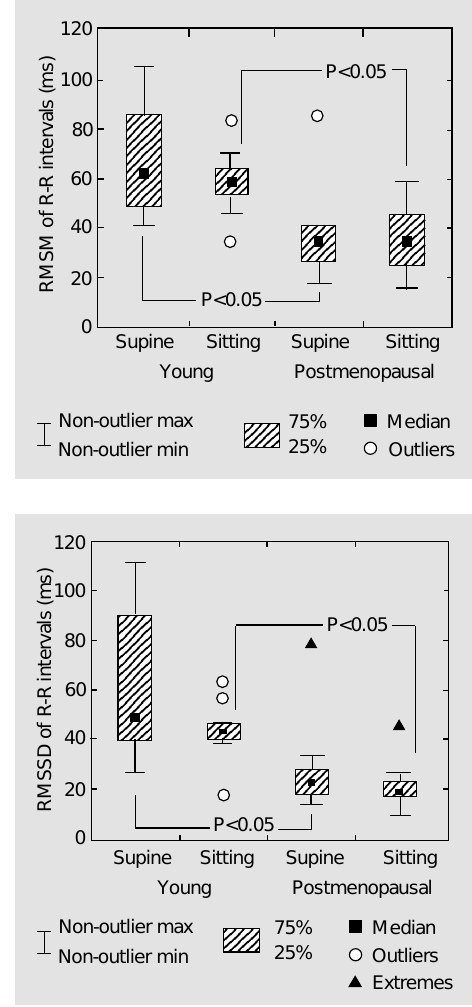
Figure 3. RMSM indexes, the standard deviation of R-R inter- vals, in ms, for the young group (N = 10) and the postmeno- pausal group (N = 10) under rest- ing conditions in the supine and sitting positions.